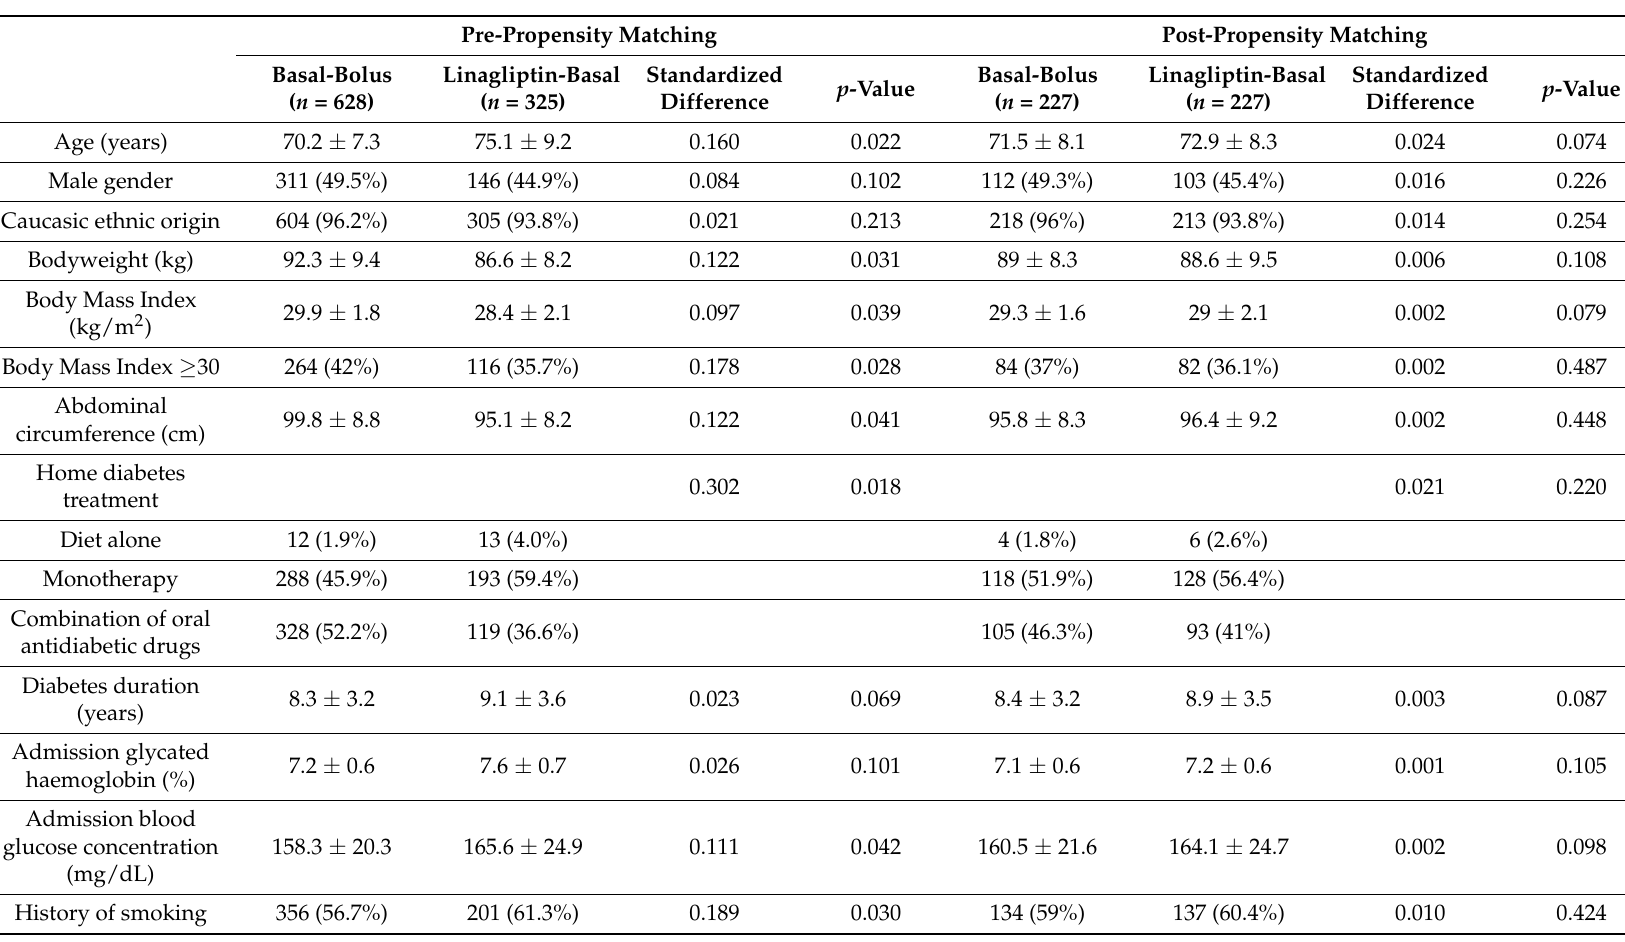
Table 2. Pre- and post-propensity matching baseline clinical characteristics of hospitalized patients with type 2 diabetes grouped by hospital antidiabetic regimen. Pre-Propensity Matching Post-Propensity Matching Basal-Bolus Linagliptin-Basal ( n = 628)